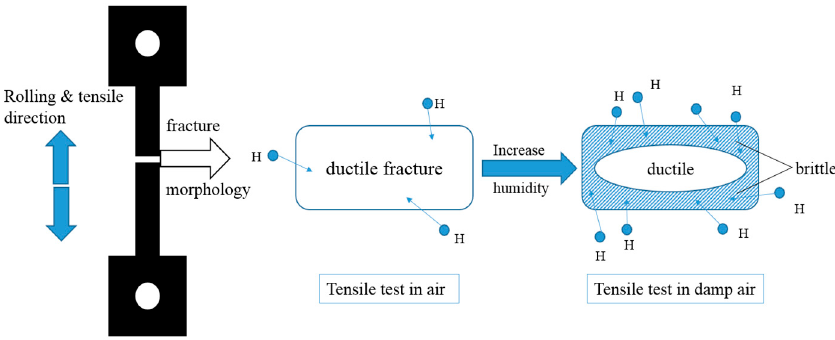
Figure 8. Schematic diagram of the hydrogen influence on the sample fracture.